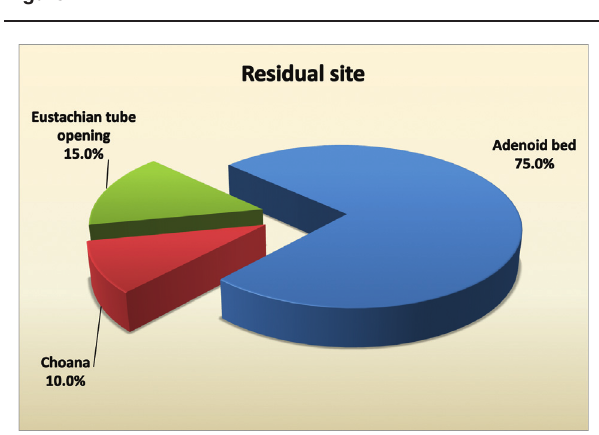
Gender distribution in both groups showing no statistical difference.